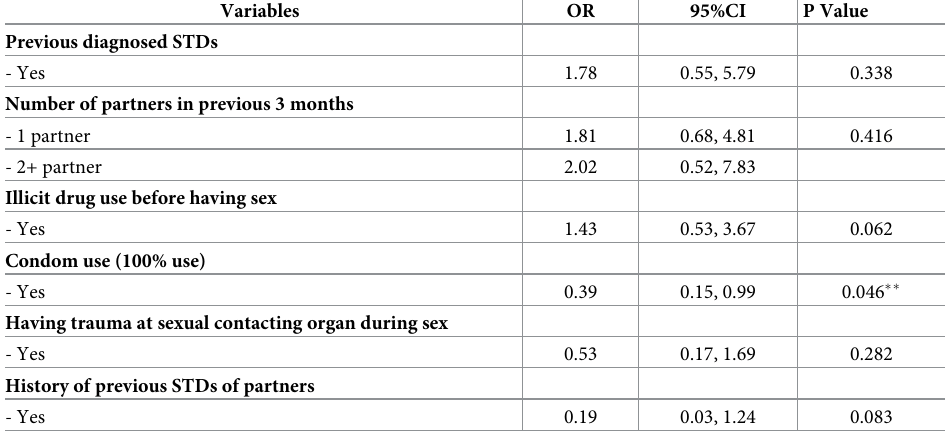
Table 5. Adjusted odds ratio for each selected factors associated with gonorrhea by total anatomic sites using multivariate